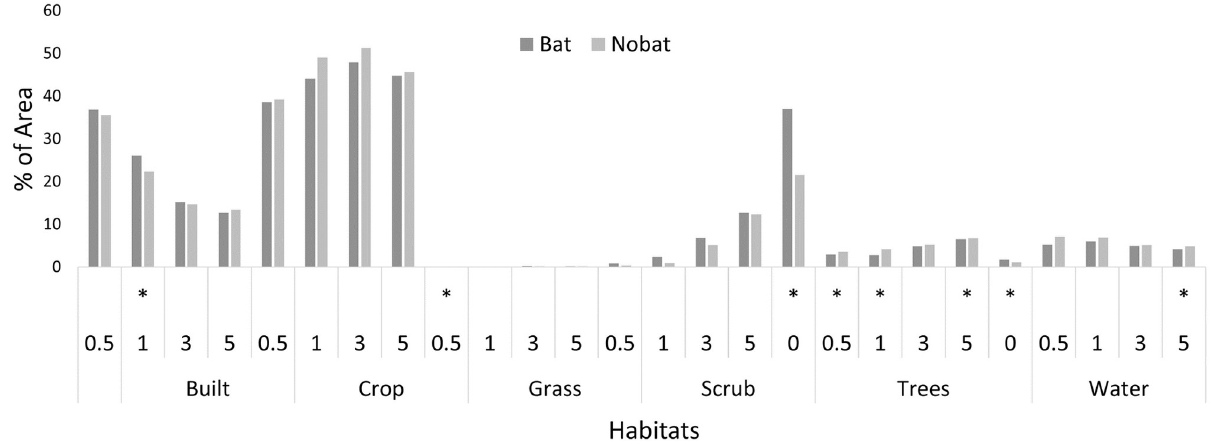
Fig 6. Mean land-use elements around temples with and without bats at various distances. � indicates significant differences at p <